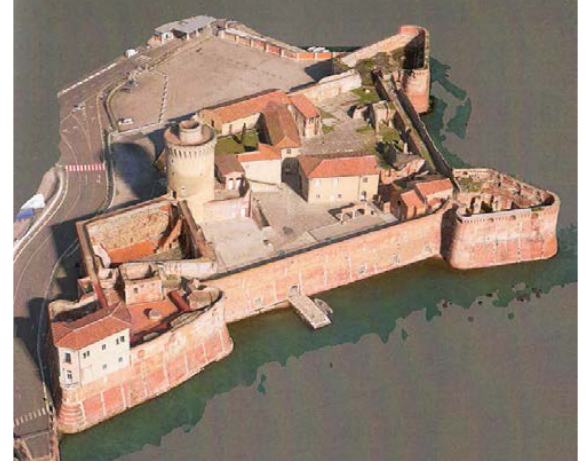
Figure 1: 3D model of the Fortezza